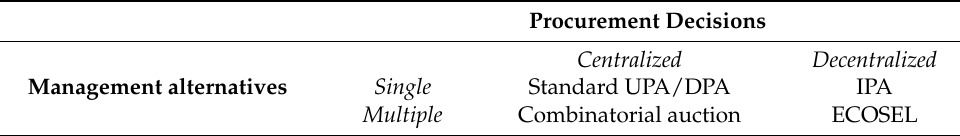
Table 3. Mechanisms by locus of decision-making and number of